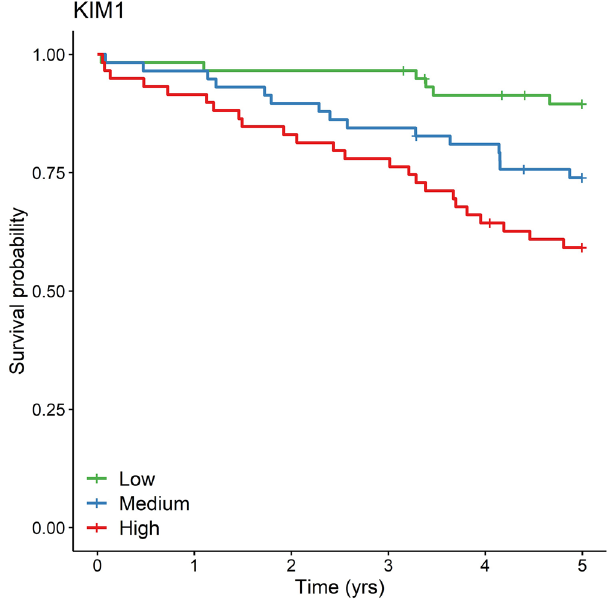
Figure 5. Kaplan–Meier Curve for All-Cause Mortality by KIM1 level in in CATHGEN. The Kaplan–Meier curve shows overall survival for CATHGEN participants by KIM1 levels. KIM1 was the protein most strongly associated in the meta-analysis for all-cause mortality.